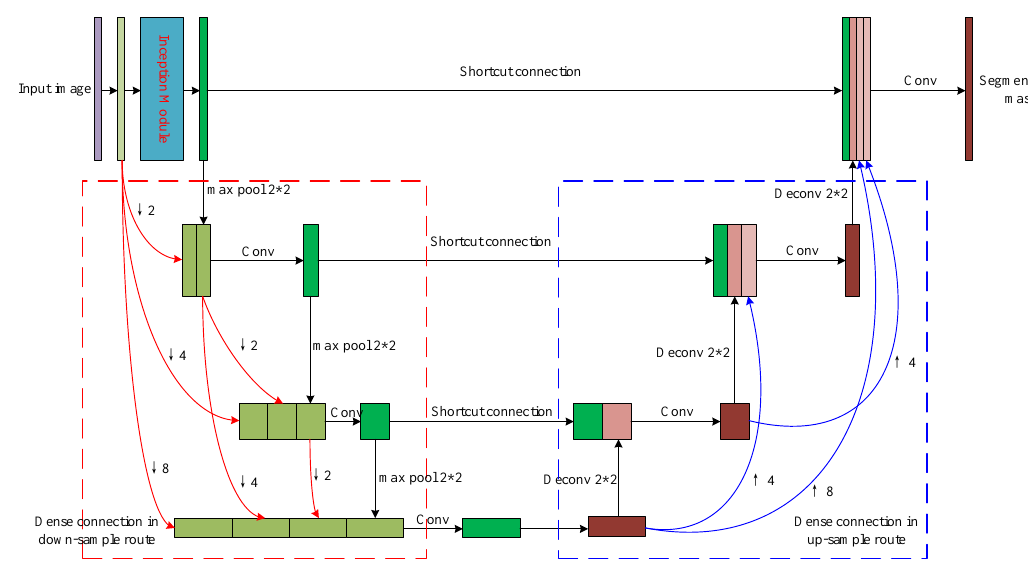
Figure 2. The structure of the proposed sub-network for lung parenchyma segmentation.